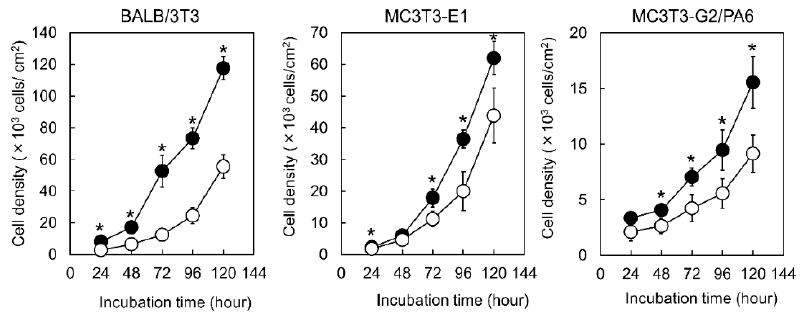
Figure 4. Growth curves of BALB/3T3, MC3T3-E1, and MC3T3-G2/PA6 cells on the surface of Me- PRX (closed circles) and TCPS (open circles) during a 5-day cultivation period. The initial cell seeding density was 2.0 × 10 3 cells/cm 2 . Data are presented as mean ± standard deviation (S.D.), n = 4. * p < 0.05 (Student’s t -test).